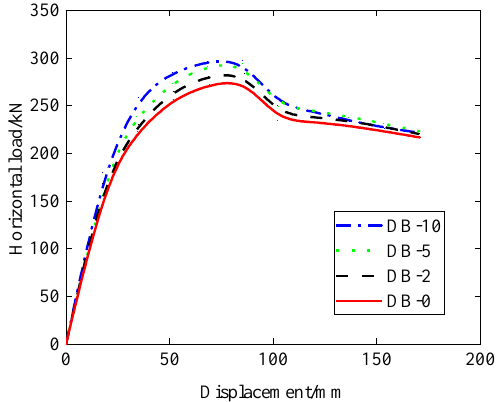
Figure 13. Load – displacement curve (effect of embedment depth). Figure 13. Load–displacement curve (effect of embedment